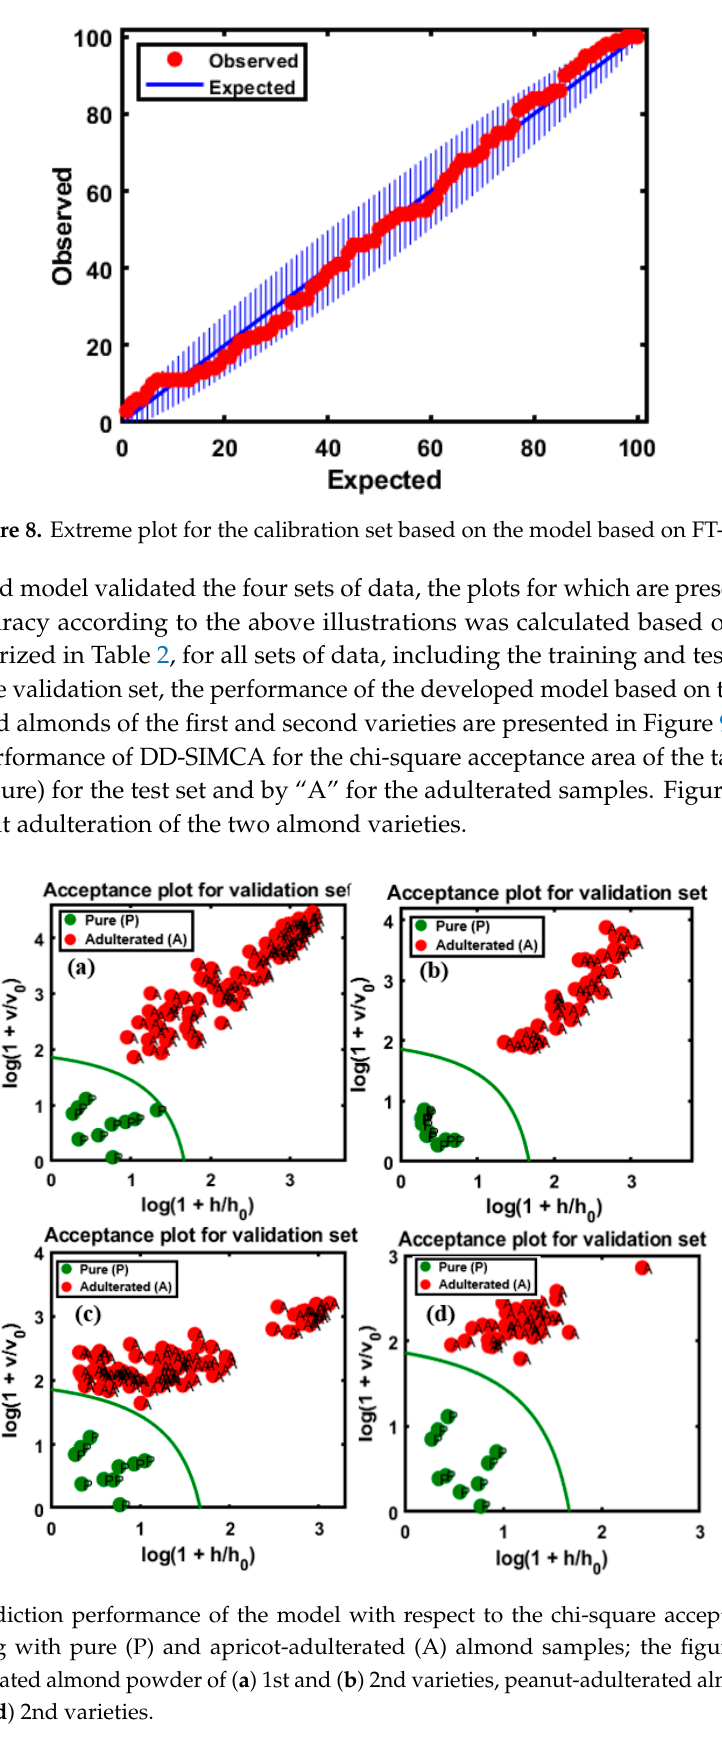
Figure 9. Prediction performance of the model with respect to the chi-square acceptance area of class modeling with pure (P) and apricot-adulterated (A) almond samples; the figures represent apricot-adulterated almond powder of ( a ) 1st and ( b ) 2nd varieties, peanut-adulterated almond powder of ( c ) 1st and ( d ) 2nd